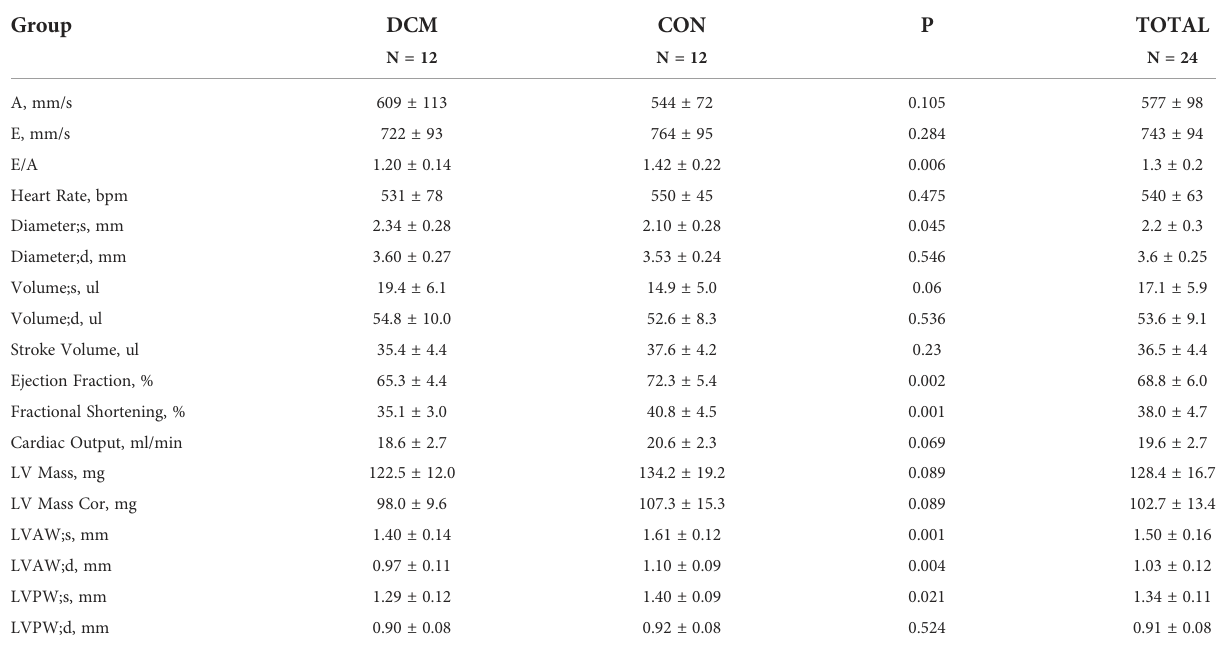
TABLE 1 Ultrasound in mice.